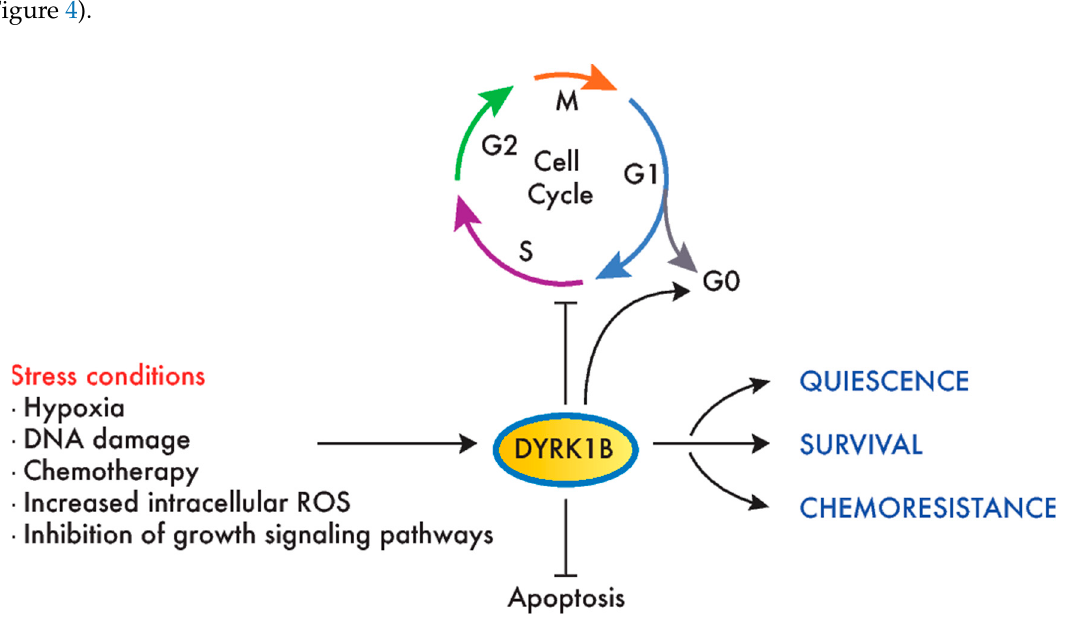
Figure 4. DYRK1B promotes survival and chemoresistance in cancer cells. Environmental stress conditions induce DYRK1B expression or activity in tumor cells, which, in turn, promotes cell cycle exit, quiescence (entry in G0) and survival. This mechanism has been proposed to mediate the resistance to chemotherapeutic agents that target dividing cells.